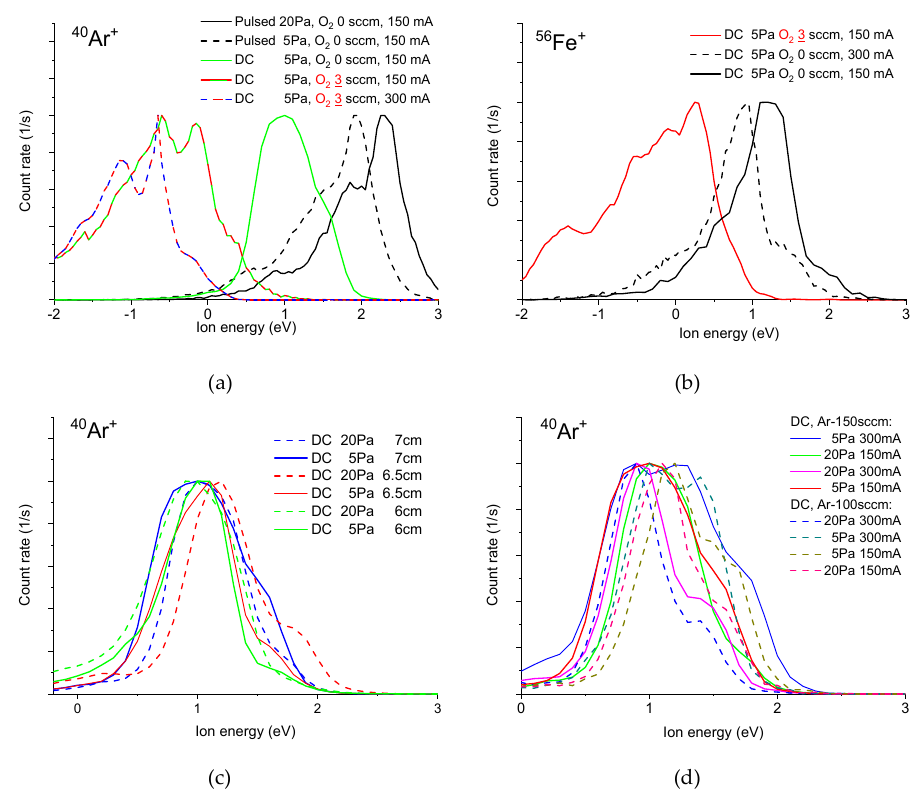
Figure 3. Energetic spectra for argon in DC and pulsed DC modes ( a ) and iron in DC mode ( b ). Energetic spectra for argon in DC mode for different pressures and distances from cathode ( c ) and argon flow rates ( d ). Default parameters: distance from cathode 7 cm, Ar flow 150 sccm, O 2 flow 0 sccm, discharge current 150 mA and pulsed mode duty cycle 10 % at frequency 1 kHz.